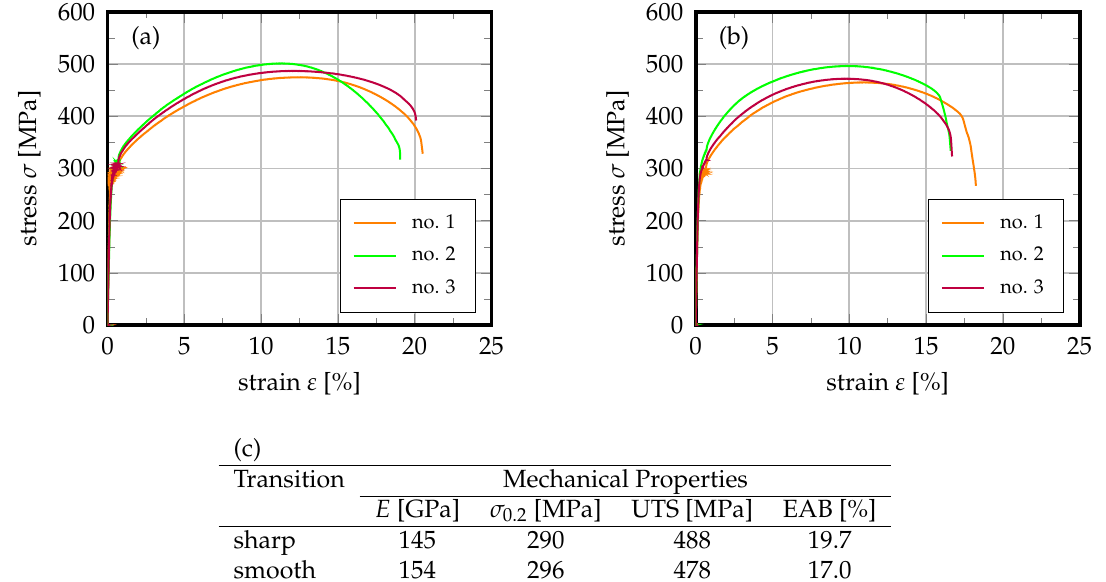
Figure 9. Results of tensile tests for specimens with ( a ) sharp and ( b ) smooth transition of AISI316L and CoCrMo as well as ( c ) summary of mechanical properties, averaging three measurements for each